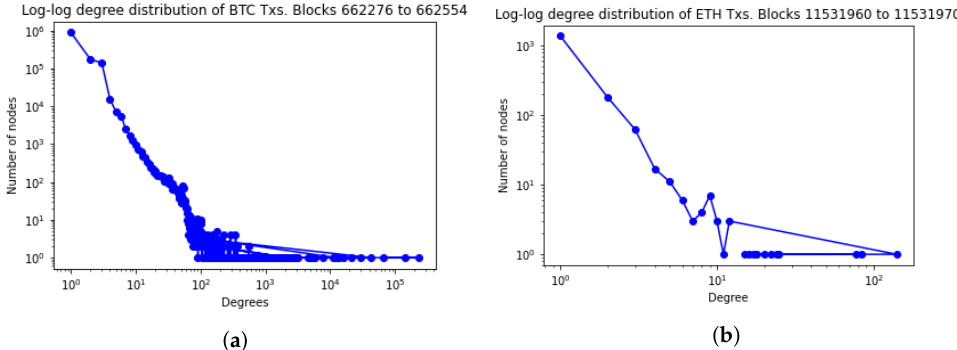
Figure 1. Typical power-law transaction degree distributions. ( a ) BTC degree distribution. ( b ) ETH degree distribution. Table 1. Simulation parameters related to BTC and ETH degree